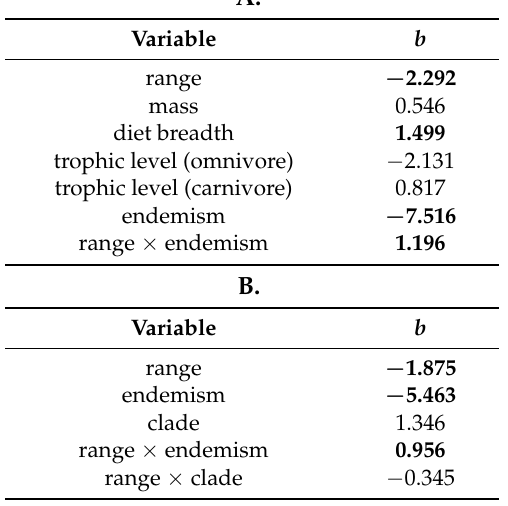
Table 3. Details of the best-fit models. Regression coefficients ( b ) are bolded for variables significant at p ≤ 0.05 according to a Wald test. A. The predictor-rich model ( n = 345). B. The taxon-rich model ( n =